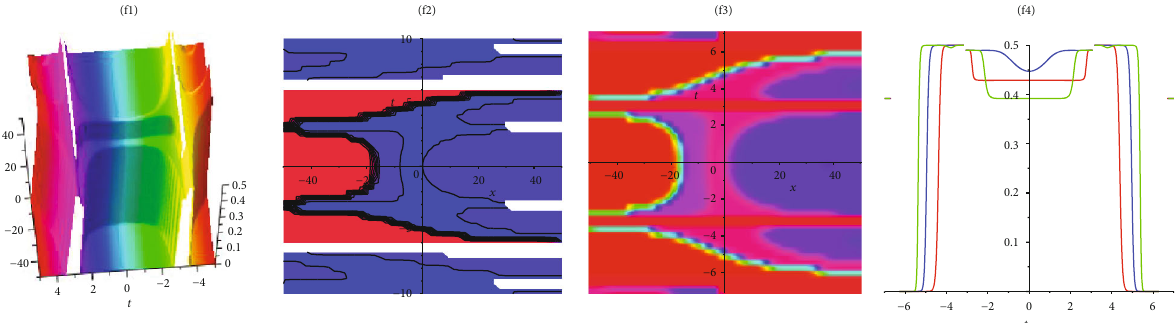
= 1, α = 1 : 5, α = 2, β = 1 : 5, β 1 2 3 1